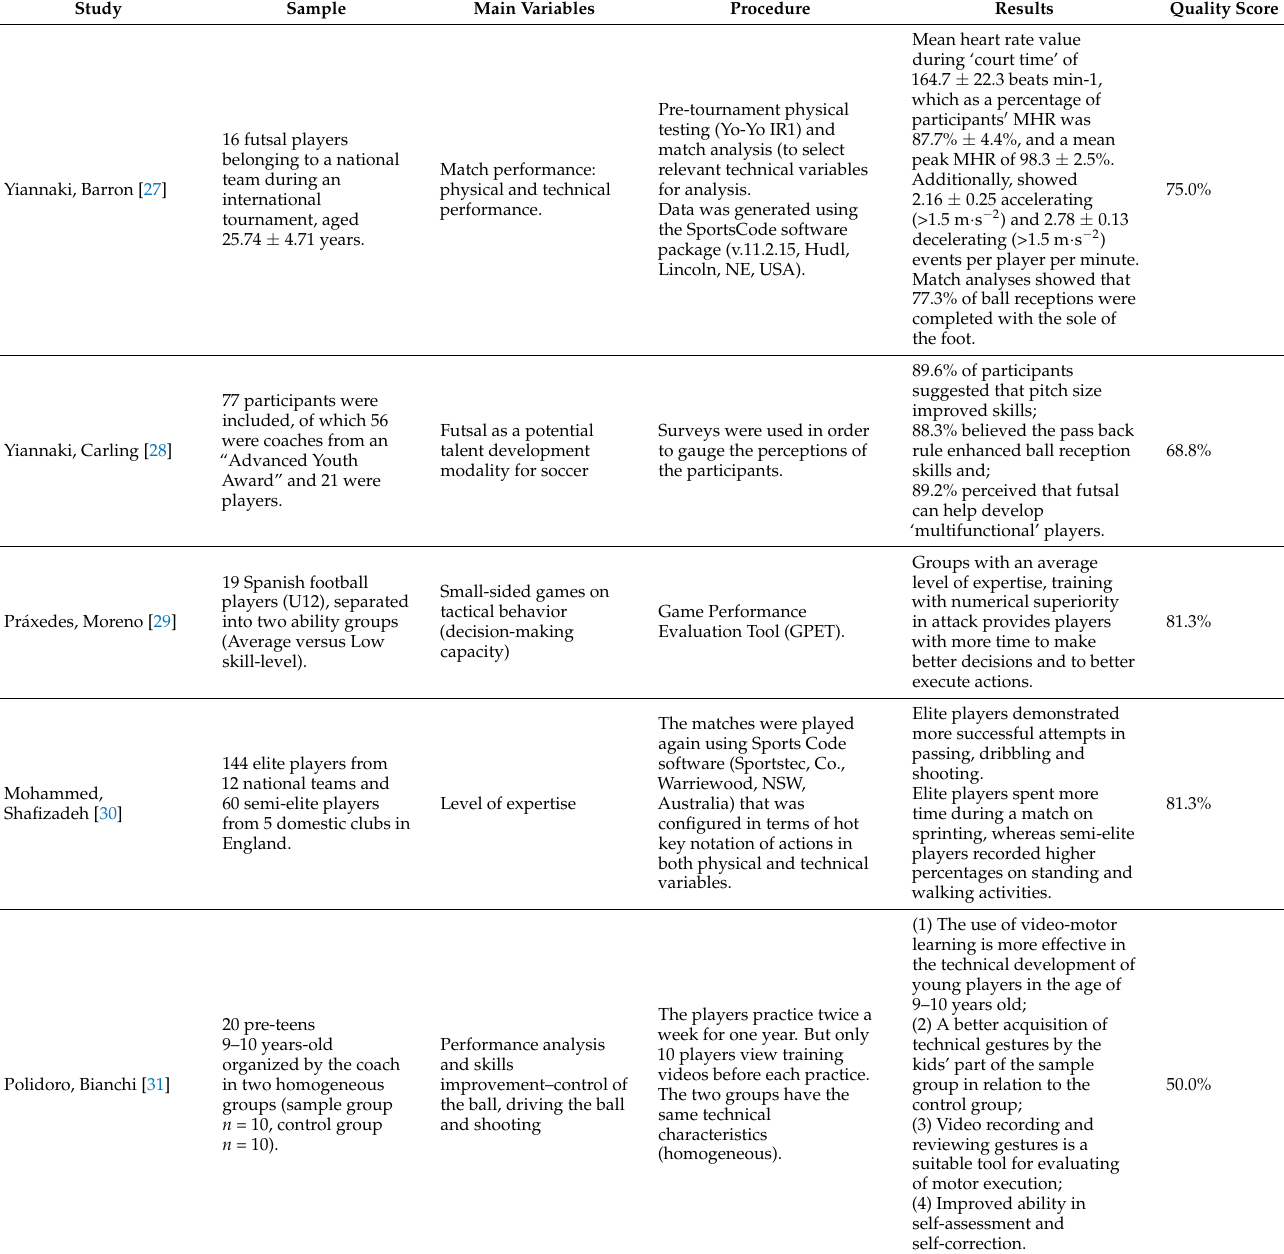
Table 5. Studies with predominantly technical and tactical skill